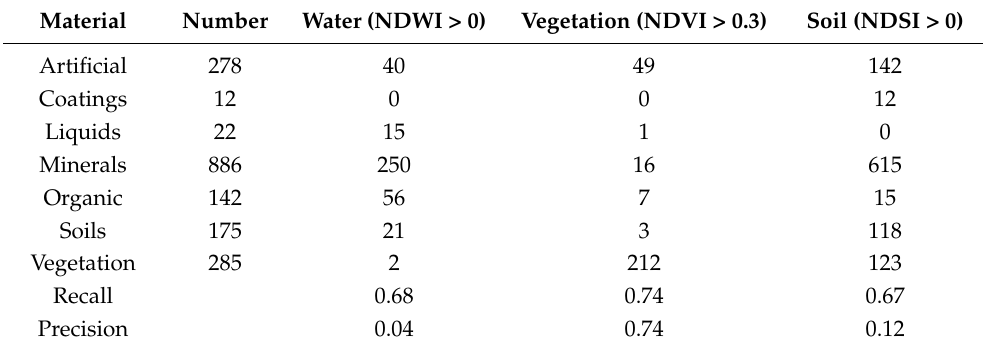
Table 2. Number of spectra that are identified as specified materials with different NDIs using various threshold values on the USGS spectral library (spectra resampled to Landsat-8 bands).